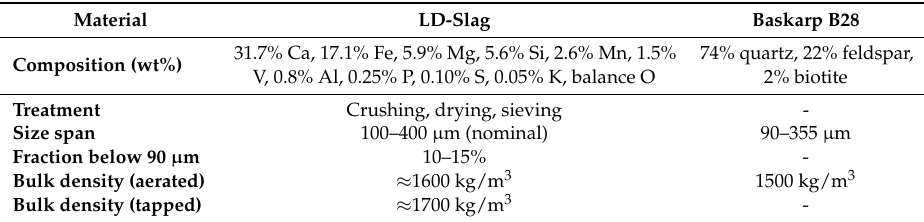
Table 1. Characteristics of bed material.